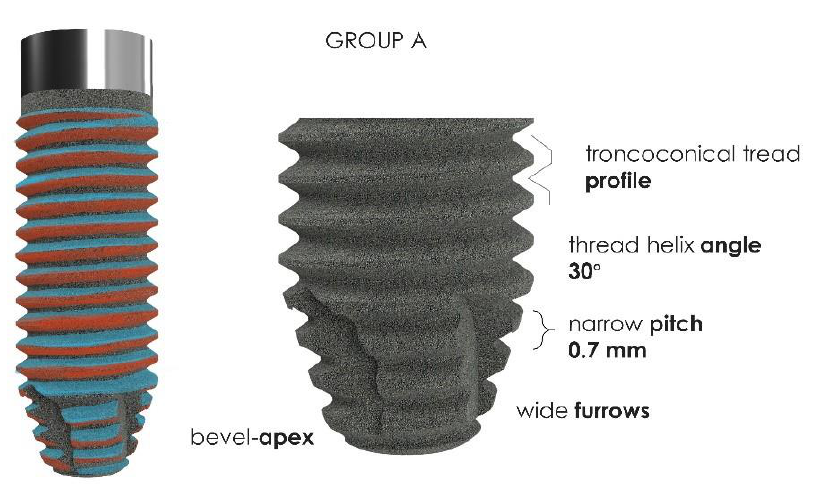
Figure 1. Group A: in detail, the morphology and thread geometry of the cylindrical implants.